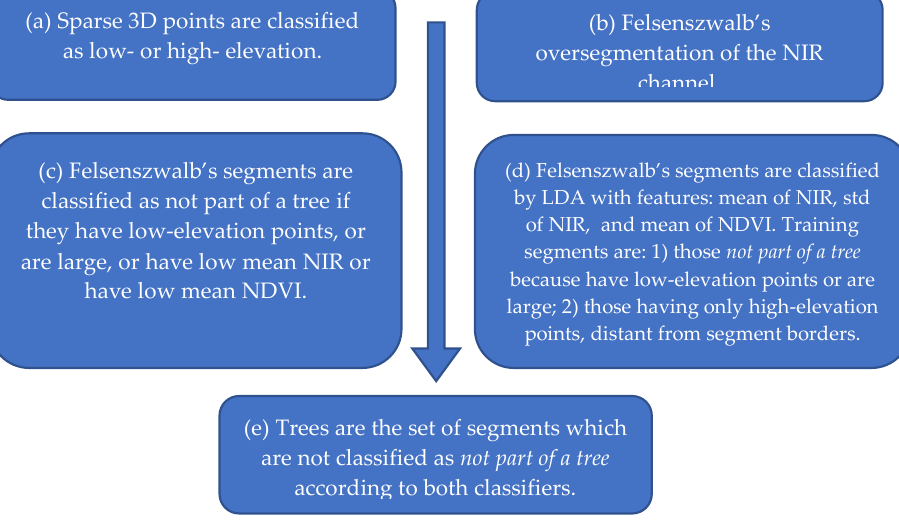
Figure 7. Steps of the tree segmentation